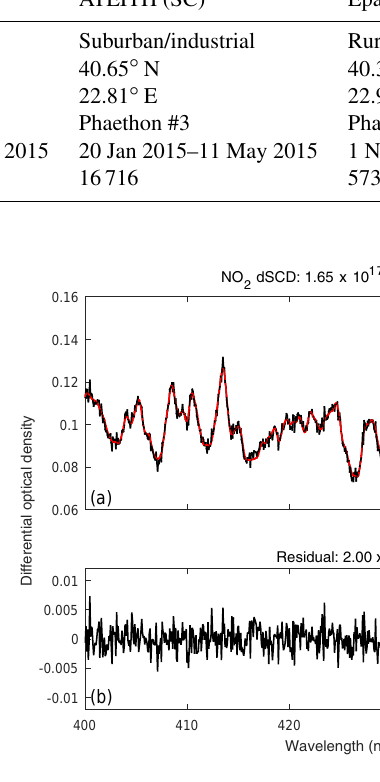
Figure 2. Example of NO 2 fitting results obtained at the UC site on 6 November 2014, around 10:30UTC, at an elevation angle of 5 ◦ and a solar zenith angle (SZA) ∼ 57 ◦ . The upper panel shows the measured (black) and the fitted (red) NO 2 , and the lower panel shows the residual of the DOAS